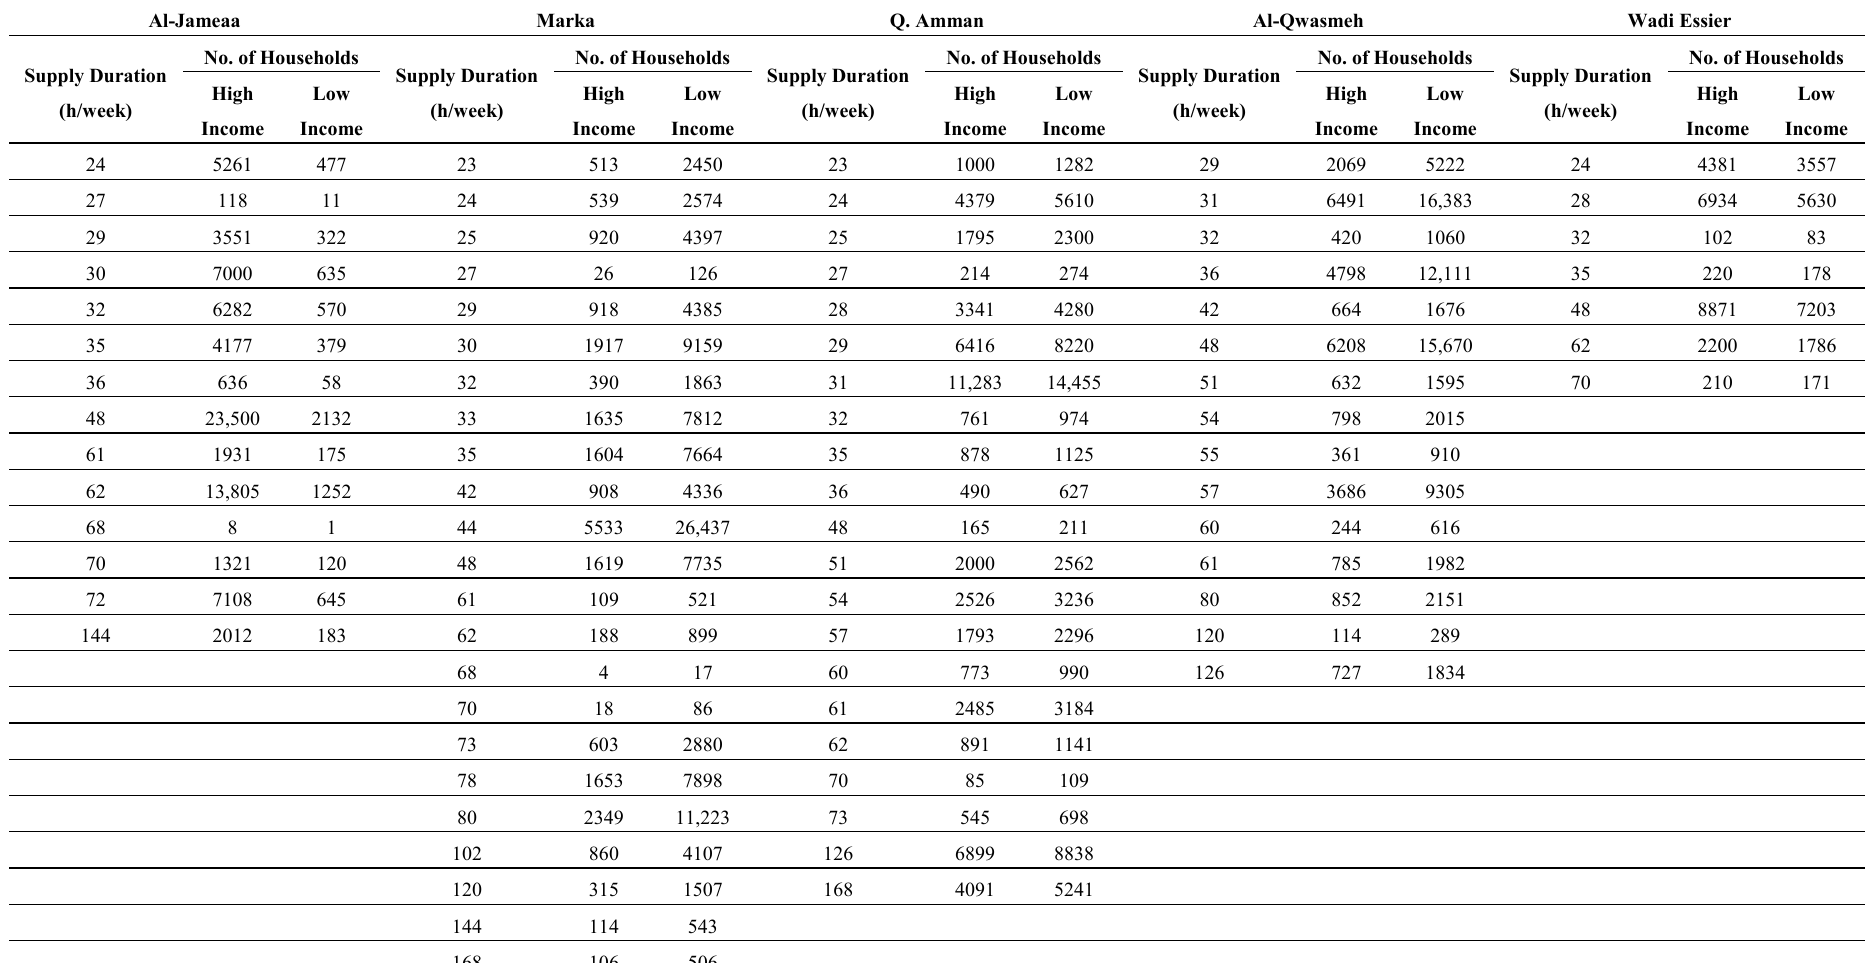
Table A1. Definition of agent district, population, supply duration, and income